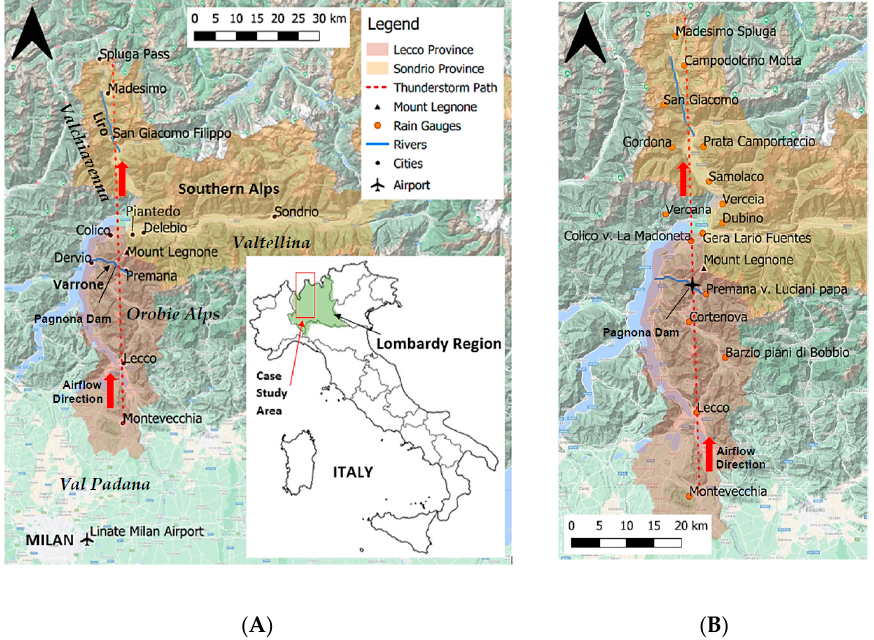
Figure 1. ( A ) The case study area in the Lecco and Sondrio Provinces (Lombardy Region, Italy) with affected municipalities and infrastructures; ( B ) the local rain gauges network from Arpa Lombardia with the south-north airflow direction along the thunderstorm path (dotted red line).